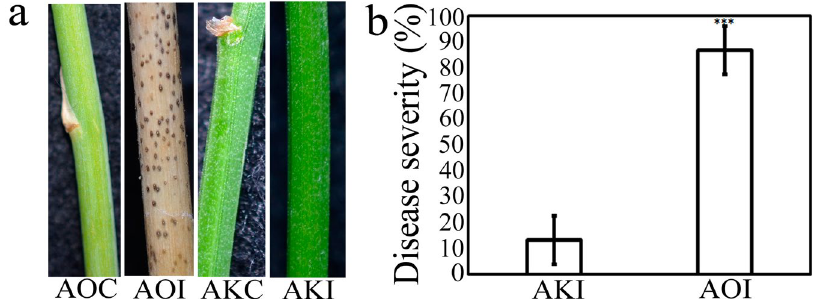
Figure 1. Stem blight disease symptoms in cultivated Asparagus officinalis and wild A . kiusianus 3 weeks after inoculation with Phomopsis asparagi . ( a ) Disease symptoms in A . officinalis treated with sterile distilled water (AOC), A . officinalis inoculated with P . asparagi (AOI), A . kiusianus treated with sterile distilled water (AKC), and A . kiusianus inoculated with P . asparagi (AKI). ( b ) Disease severity percentage in AKI and AOI plants. Values represent the mean ± standard error (SE) of three independent replicates ( n = 3). Asterisks indicate significant difference between AOI and AKI plants as determined by Student’s t -test ( *** P <